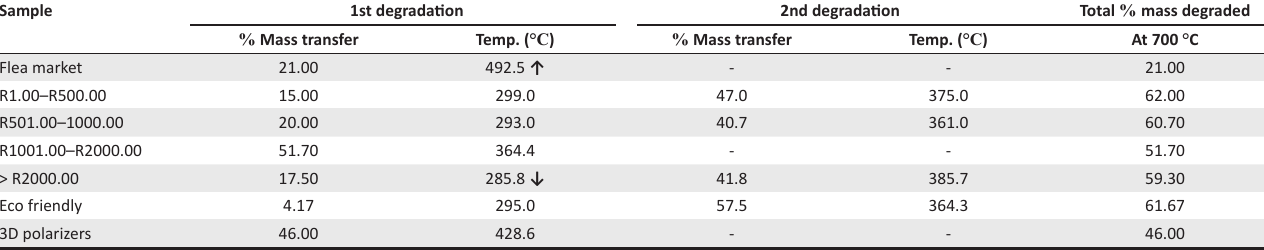
TABLE 3: Thermal decomposition of plastic frames using thermogravimetric analysis versus price categories. Sample 1st